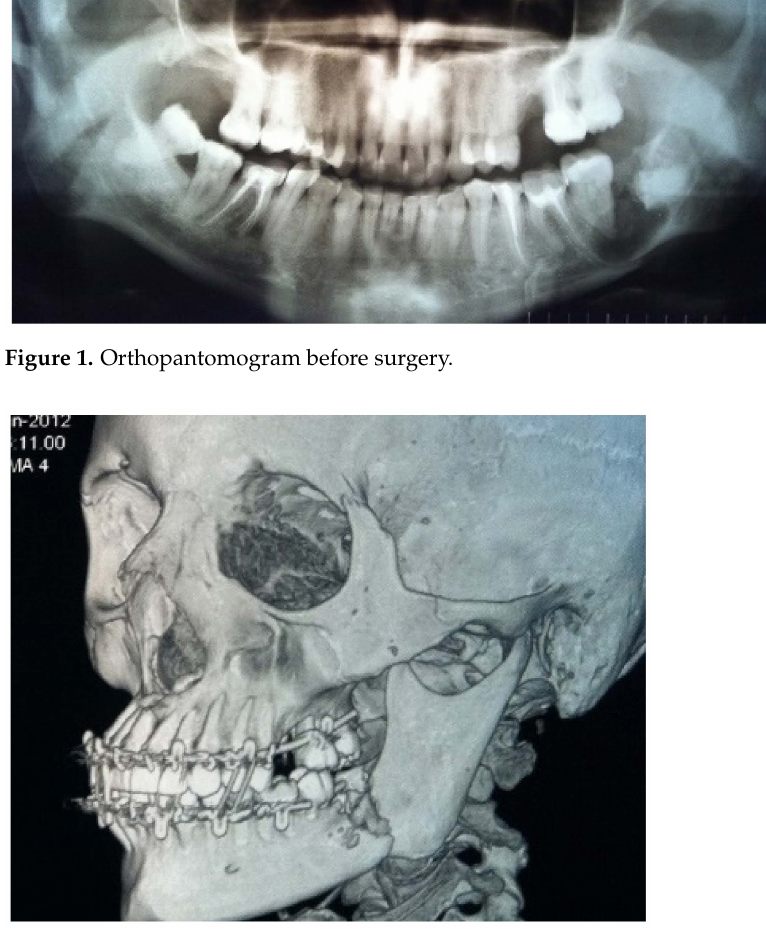
Figure 2. Patient’s CBCT at